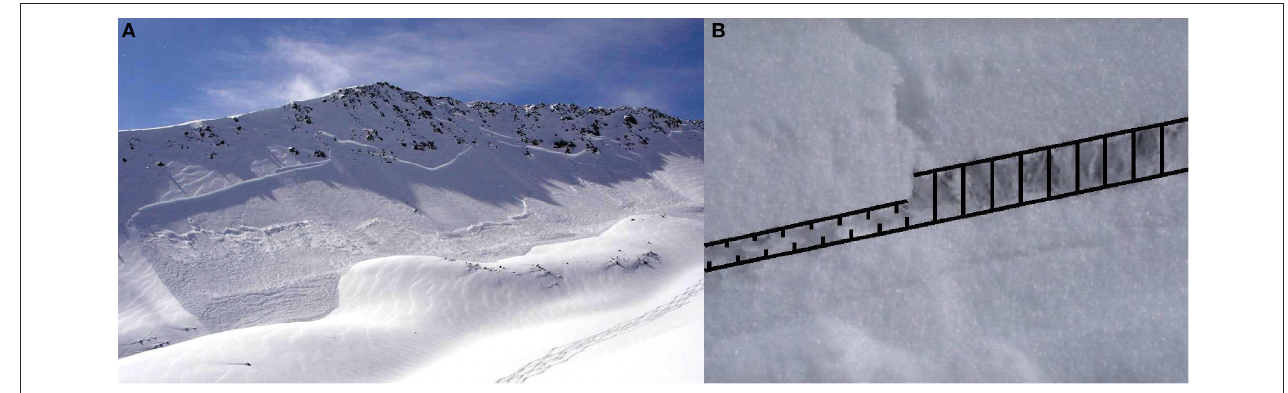
FIGURE 3 | (A) Dry-snow slab avalanche (R. Pajarola). (B) Snow weak layer (surface hoar) buried below a cohesive slab. On the right side the weak layer is intact. On the left side the weak layer failed leading to volumetric collapse of the porous structure. The black lines are a schematic representation of the FBM. Reprinted from the Journal of Glaciology with permission of the International Glaciological Society